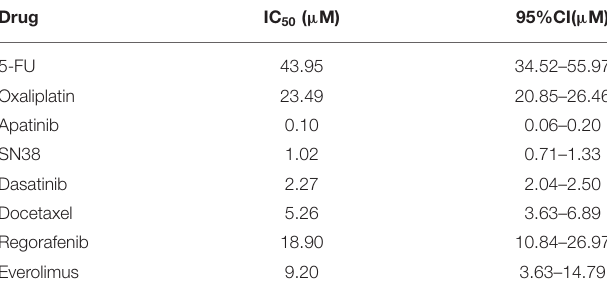
TABLE 1 | IC 50 values for each drug and confidence intervals (CIs) for the